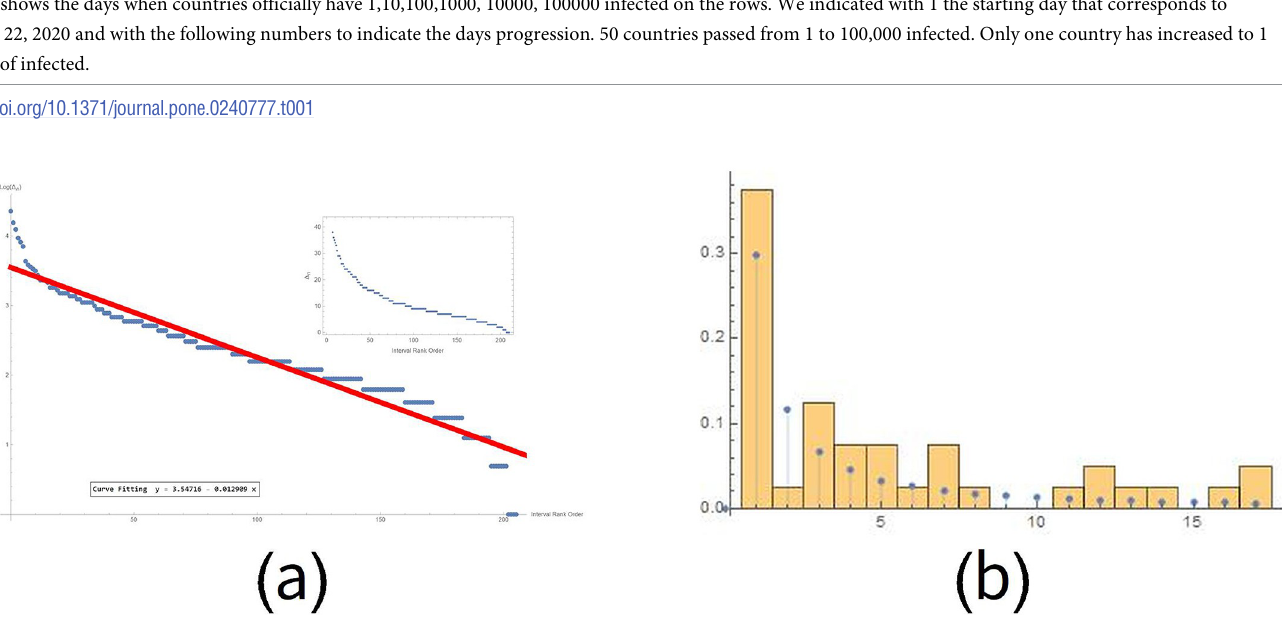
Table 2. Interpolation lines.